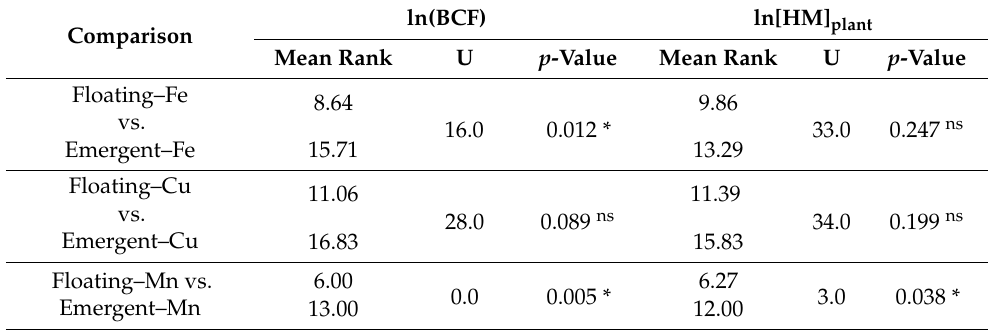
Table 2. Comparison between emergent and floating biotopes in the absorption of Fe, Cu and Mn. ln(BCF) ln[HM] plant Comparison Mean Rank U p -Value